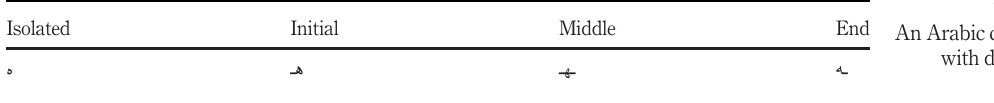
Table I. An Arabic character